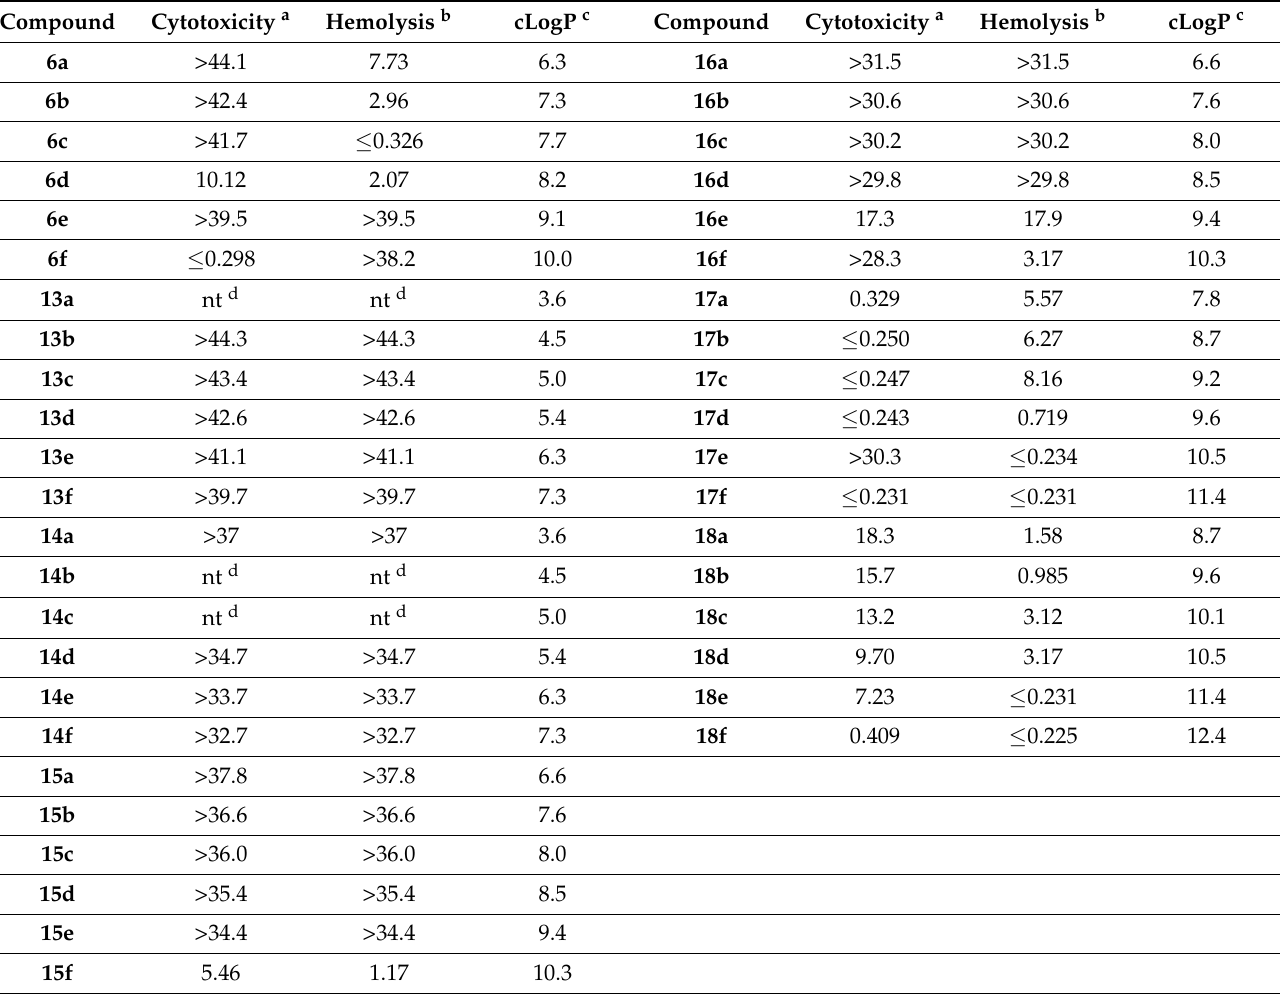
a Concentration of compound at 50% cytotoxicity on HEK293 human embryonic kidney cells and values presented as the mean ( n = 2). Highest dose tested was 32 µ g/mL. Tamoxifen was the positive control (IC 50 24 µ M); b concentration (HC 10 , µ M) of compound at 10% hemolytic activity on human red blood cells and values presented as the mean ( n = 2). Melittin was the positive control (HC 10 0.95 µ M); c cLogP values calculated in DataWarrior v05.05.00 [32]; d not